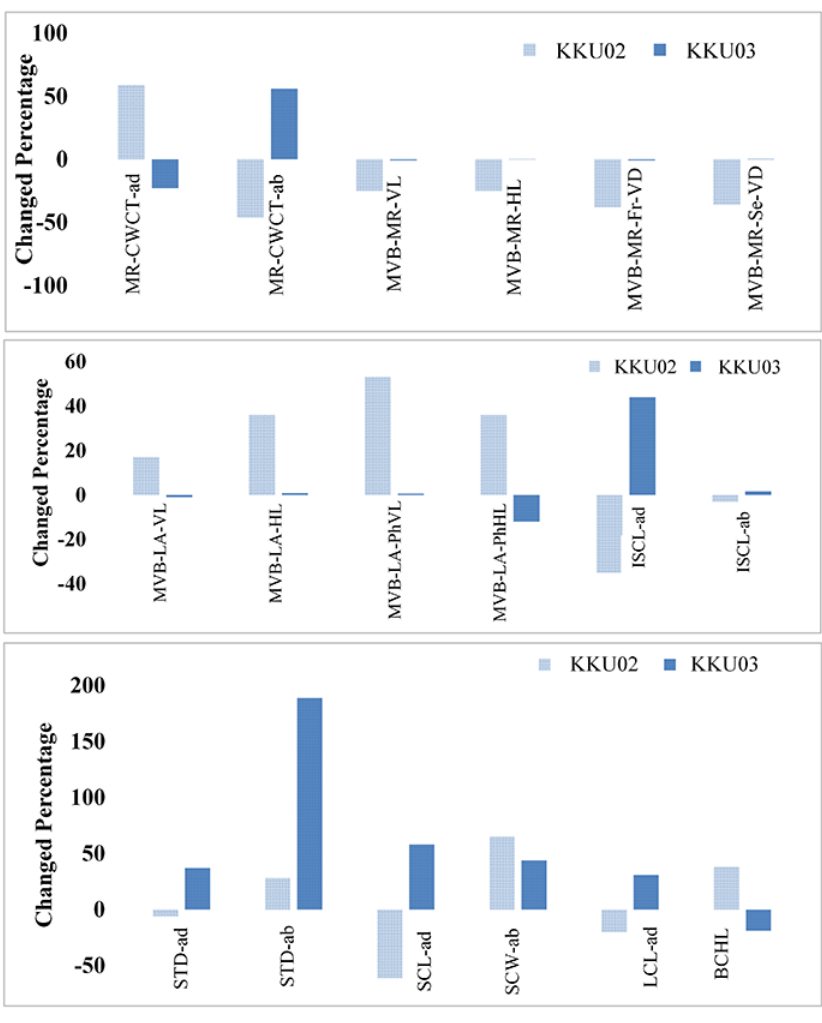
Figure 3 Increasing or decreasing percentage of some significant anatomical traits of sugarcane cultivars, KKU-1999-02 and KKU-1999-03, aer drought stress treatment. MR-CWCT-ad = midrib epidermal cell wall and cuticle thickness (adaxial); MR-CWCT-ab = midrib epidermal cell wall and cuticle thickness (abaxial); MVB-MR-VL = major vascular bundle of midrib (vertical length); MVB-MR-HL = major vascular bundle of midrib (horizontal length); MVB-MR-Fr-VD = major vascular bundle of midrib (first vessel diameter of metaxylem); MVB-MR-Se-VD = major vascular bundle of midrib (second vessel diameter of metaxylem); MVB-LA-VL = major vascular bundle of lamina (vertical length); MVB-LA-HL = major vascular bundle of lamina (horizontal length); MVB-LA-PhVL = major vascular bundle of lamina (phloem vertical length); MVB-LA-PhHL = major vascular bundle of lamina (phloem horizontal length); ISCL-ad = interstomatal cell length (adaxial); ISCL-ab = interstomatal cell length (abaxial); STD-ad = stomatal density (adaxial) (No./mm 2 ); STD-ab = stomatal density (abaxial) (No./mm 2 ); SCL-ad = short cell length (adaxial); SCW-ab = short cell width (abaxial); LCL-ad = long cell length (adaxial); BCHL = bulliform cell horizontal length.